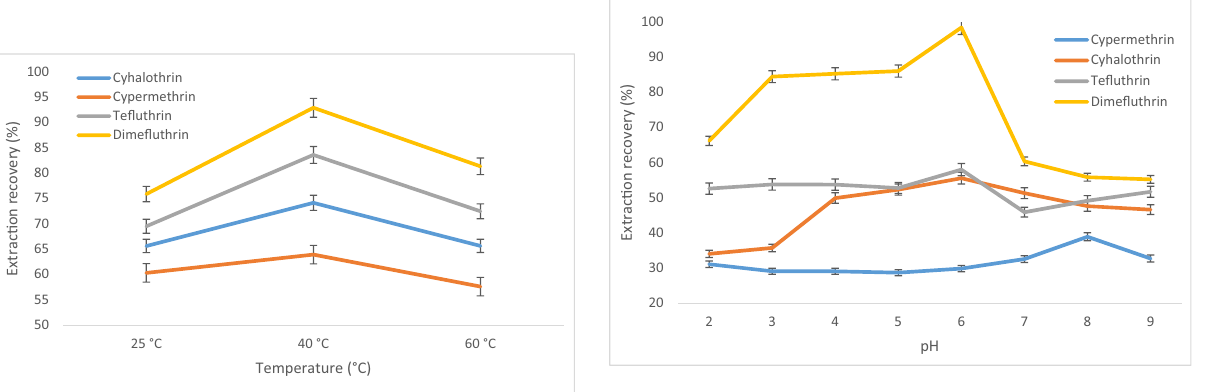
Figure 6: E ff ect of pH of solution on the e ffi ciency of extraction ( extraction conditions: 100 µL of 100 ng L − 1 of each analyte; extrac - tion time: 180 min; stirring speed: 700 rpm; sample volume: 20 mL; temperature: 40°C; pH: 7 )